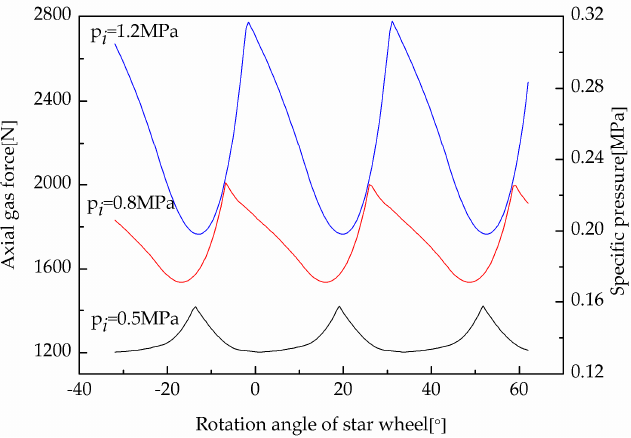
Figure 5. Variation of gas force on star wheel with rotation angle of star wheel.